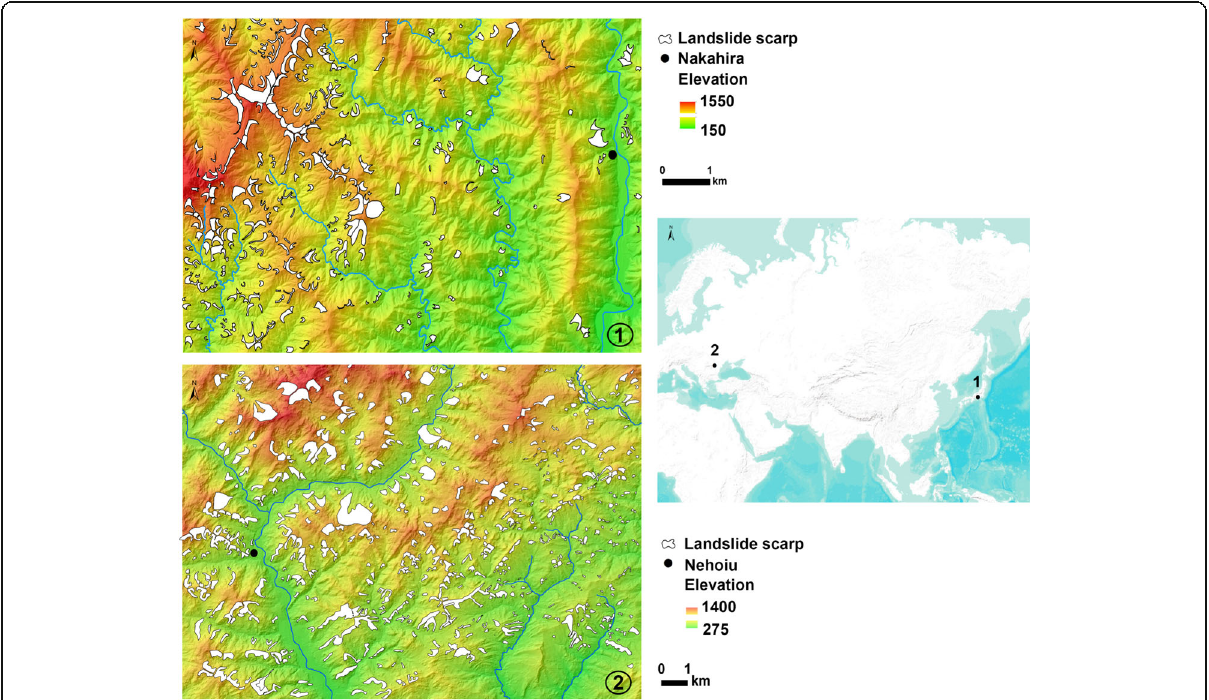
Fig. 1 Landslide scarps inventories in Shizuoka, Japan (1) and Buz ă u, Romania (2), and their locations